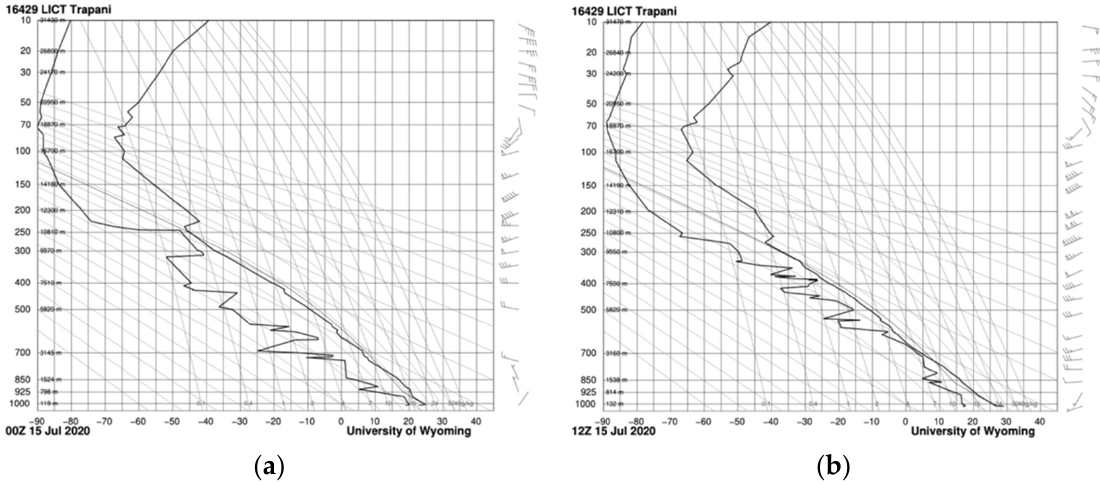
Figure 4. Radio sounding taken at Trapani (LICT) at 00:00 UTC ( a ) and 12:00 UTC ( b ) on 15 July 2020. (Source: Department of Atmospheric Science, University of Wyoming).